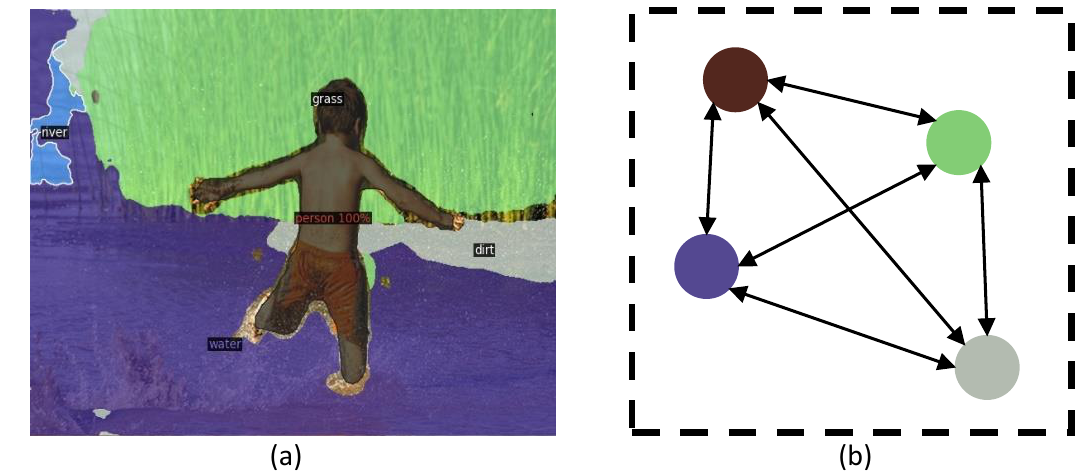
Figure 3. An example of sentiment graph: ( a ) An object segmentation result, where the objects are distinguished by different color overlay. ( b ) A sentiment graph structure, where the nodes represent objects of corresponding color and edges reflect the similarity of nodes in the sentiment